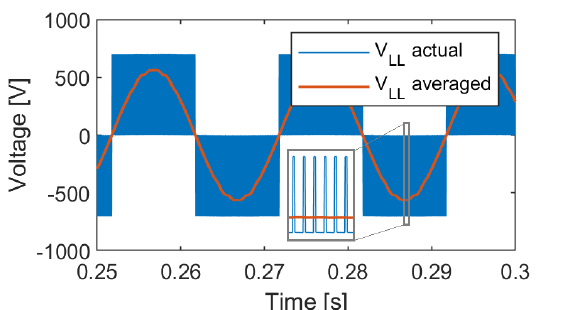
Figure 8. Two-level six-switch boost-type rectifier simulation results: line-to-line voltage.